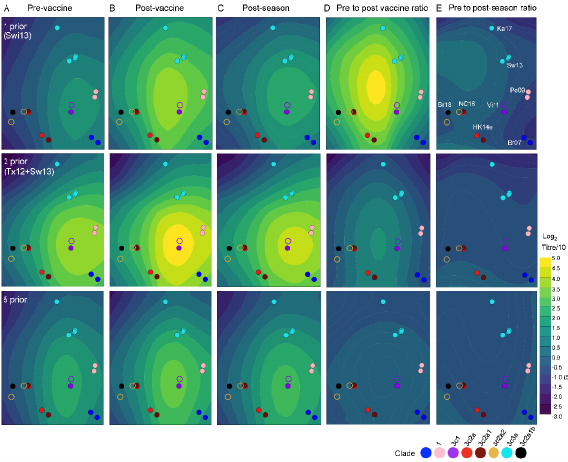
Figure 4. The strain coverage of antibodies induced by vaccination varies with vaccination history. Estimated antibody titer and titer rise landscapes are presented as contours over a two-dimensional map of A(H3N2) virus antigenic distances. Participants are grouped by number of prior vaccinations (rows). Panels show fitted titers Pre-Vaccination ( A ), Post-Vaccination ( B ), or Post-Season ( C ), and titer ratios Post-vaccination ( D ) or Post-Season ( E ). Each circle represents a virus on the map, colored by (sub)clade, assigned since 2009. Abbreviated virus names are shown in panel ( E ). Solid circles indicate viruses against which participant sera were titrated; other viruses are indicated by open circles. Model estimates were generated from 8 HCWs with 1 prior vaccination, 5 with 2 prior vaccinations, and 20 with 5 prior